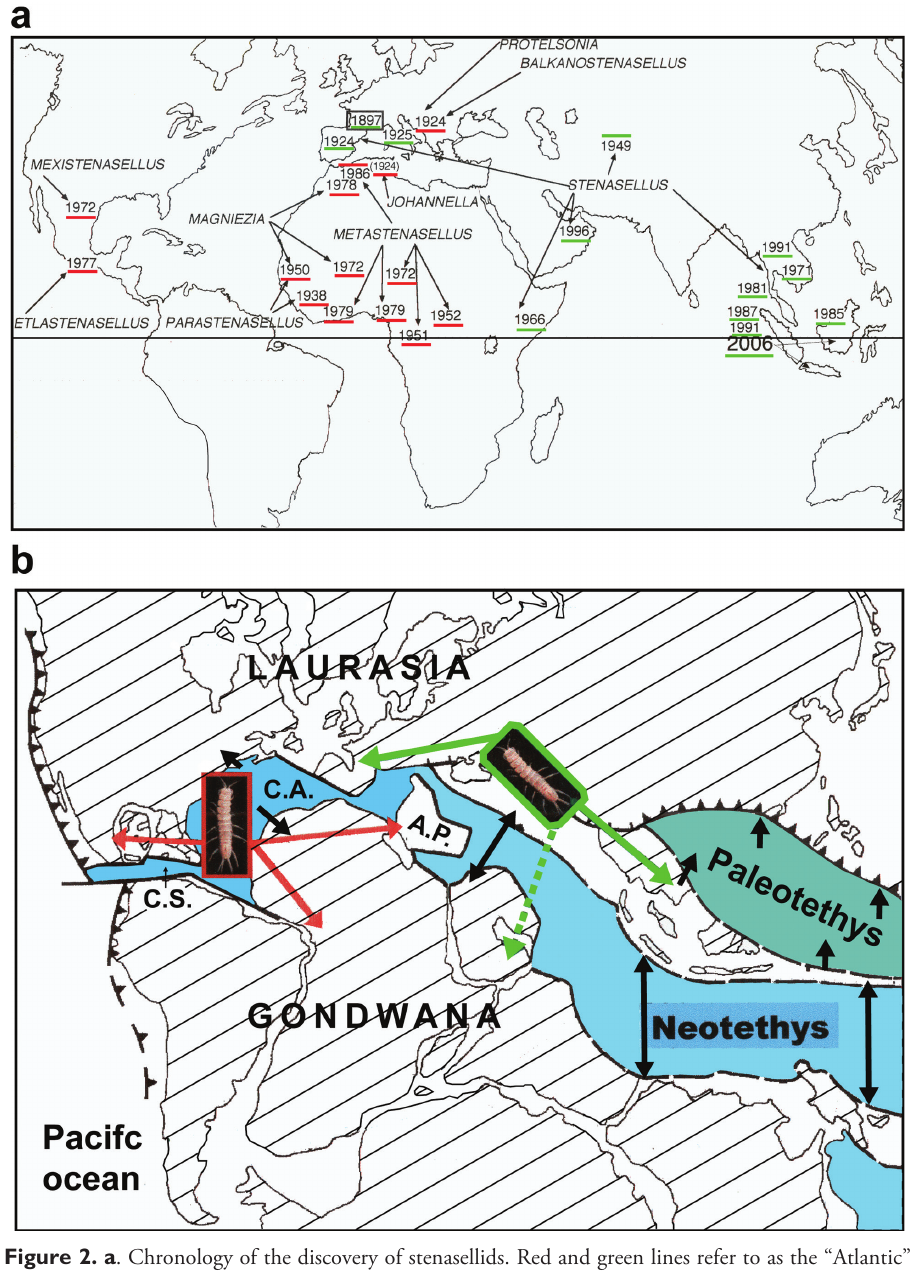
Figure 2. a . Chronology of the discovery of stenasellids. Red and green lines refer to as the “Atlantic” and “Mesogean” stocks as indicated in the lower panel. The genus Acanthastenasellus Chelazzi & Mes- sana 1985 (Somalia) was not mapped by Guy b Hypothetic colonization of groundwater by ancestor of the stenasellids. C.S. Caribbean sea C.A. Central Atlantic Ocean A.P. Apulian plate. Panels a & b are modified after Magniez (2008). The paleogeographical map in panel b was modified after Monod (2005), Encyclopaedia